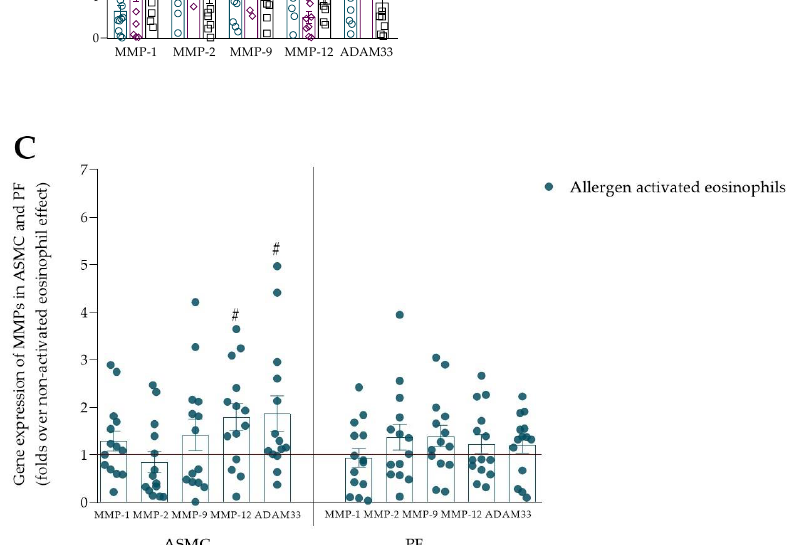
Figure 2. ( A )—Gene expression of MMPs in ASMC; ( B )—gene expression of MMPs in PF; ( C )—gene expression of MMPs in ASMC and PF after incubation with allergen-activated eosinophils. AA—allergic asthma; ADAM33—a disintegrin and metalloprotease 33; ASMC—airway smooth muscle cell; HS—healthy subject; MMP—matrix metalloproteinase; PF—pulmonary fibroblasts; SNEA—severe non-allergic eosinophilic asthma. AA, n = 13; SNEA, n = 9; HS, n = 11. Data are presented as mean ± SEM, fold change over control ASMC or PF, and fold change over non-activated AA eosinophils. * p < 0.05 compared with control ASMC or PF cells; ** p < 0.01 compared with control ASMC or PF cells; § p < 0.05 compared with HS eosinophil effect; # p < 0.05 compared with non-activated eosinophil effect. Statistical analysis between investigated groups—two-sided Mann–Whitney U test (independent data); two-sided Wilcoxon matched-pairs signed-rank test (de- pendent data); and Wilcoxon signed-rank test, which was used for gene expression analysis against control ASMC or PF that were not incubated with